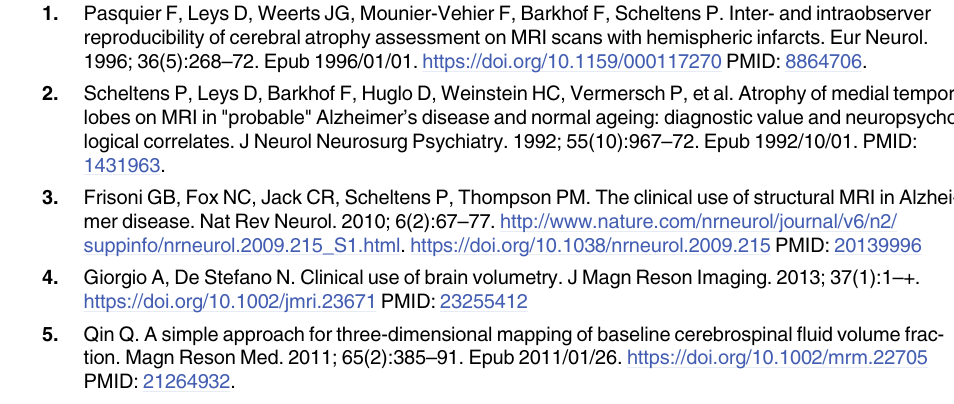
S1 Table. Correlation between the CSF MRI sequences and the LR 3D T mentation methods. S2 Table. Table regression parameters for the relationship between the CSF MRI sequences and the HR 3D T1-based brain segmentation methods. S3 Table. Table regression parameters for the relationship between the CSF MRI sequences and the LR 3D T1-based brain segmentation